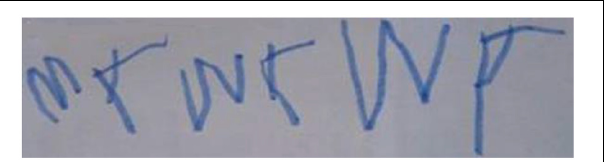
FIGURE 1 | Children in a very early stage of learning to read do not care about letter orientation, letter order or the fact that single letters represent certain phonemes. Instead, reading and writing is based on graphic features.Word: “MAMA, Artist: Anton Lachmann (4;